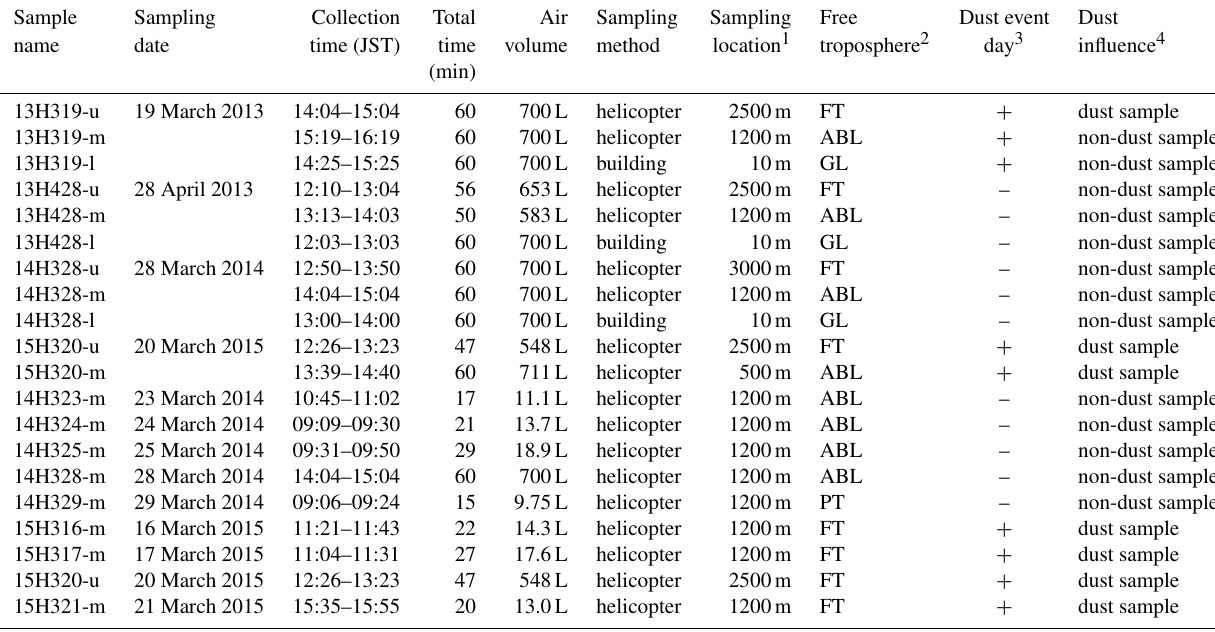
Table 1. Sampling information during the sampling periods.